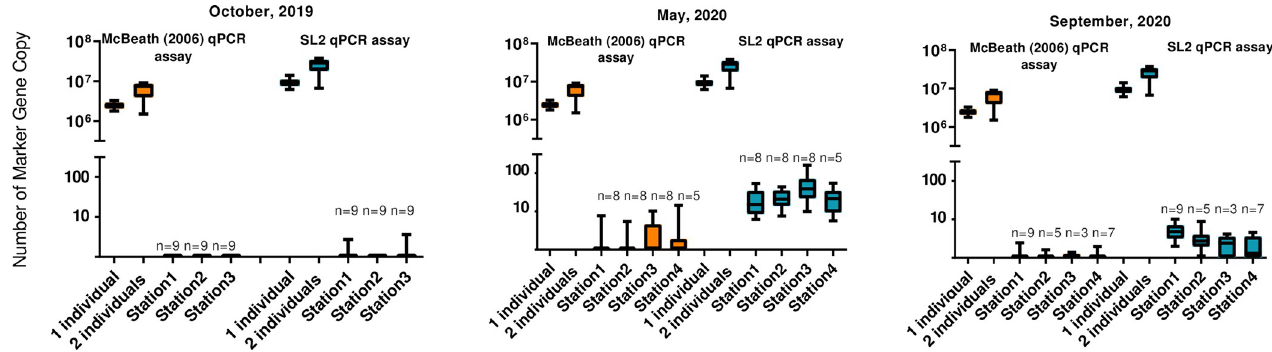
Fig 3. Number of estimated MGC in field samples (per 1 mL of seawater) collected in October 2019, May 2020, and September 2020. The field data include results obtained for samples collected from 1m, 5m, 10m depth determined by using the MC assay (orange) and the SL2 assay (blue). For the comparison, the total number of MGC corresponding to 1–2 individuals (nauplii stage) are also included in the graph. Sample size (n) is depicted for each analyzed station.